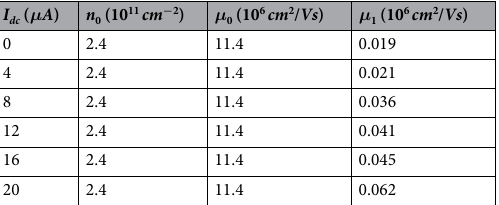
Table 1. Parameters extracted from fits of non-oscillatory giant magnetoresistance in Fig. 2(a) at various I dc , see text. Parameters n 0 , μ 0 and μ 1 were held constant as a function of P at each I dc . The parameter σ 1 has been plotted in Fig.